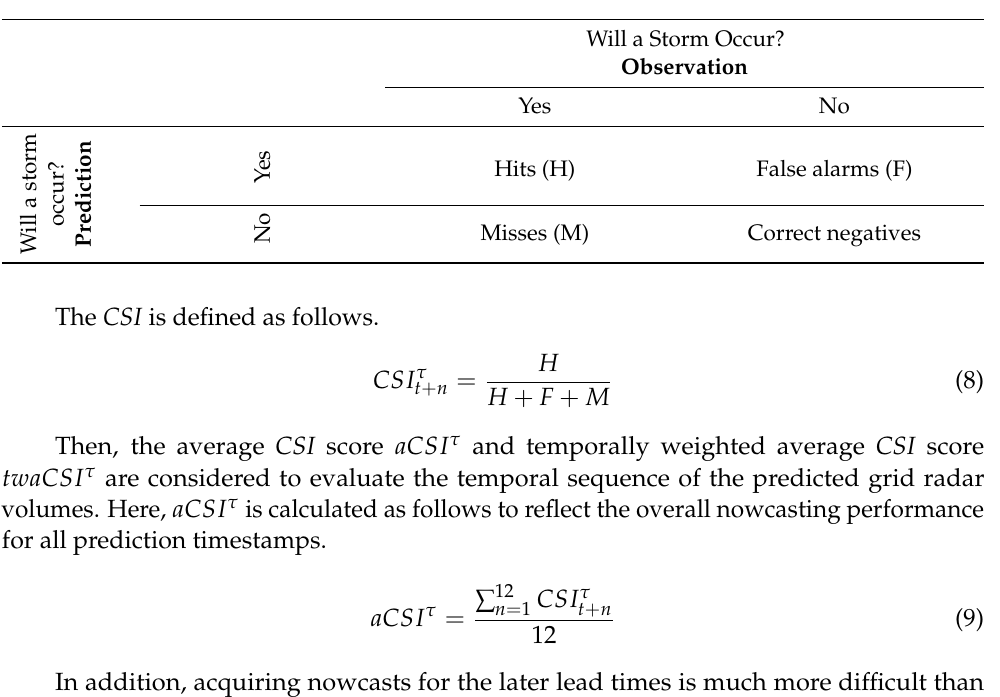
Table 5. Contingency table of